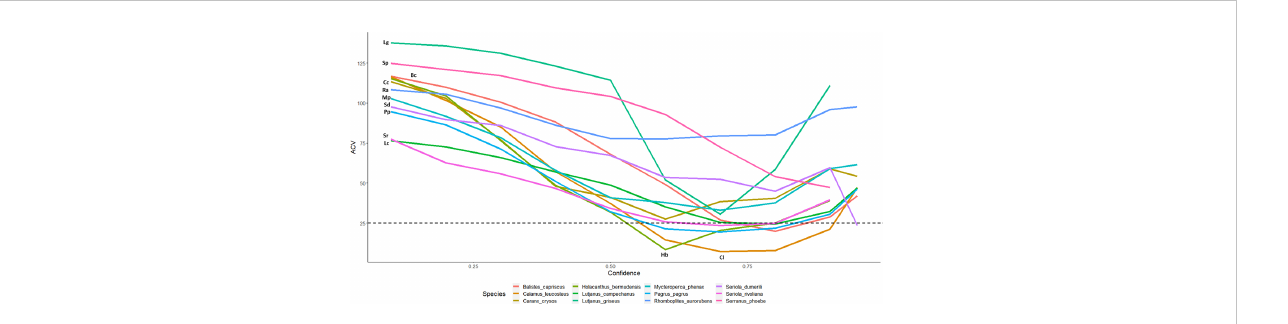
FIGURE 4 CV% for automated counts with top performing model 2.4s to expert derived counts for twelve commercially and ecologically important species of reef fi sh commonly observed in the Gulf of Mexico. Lines are labeled with the initials of the species name in the legend. Only 7 of 23 species make it below 25% threshold: B. capriscus, C. leucosteus, H. bermudensis, L. campechanus, P. Pagrus, S. dumerili, S. rivoliana .